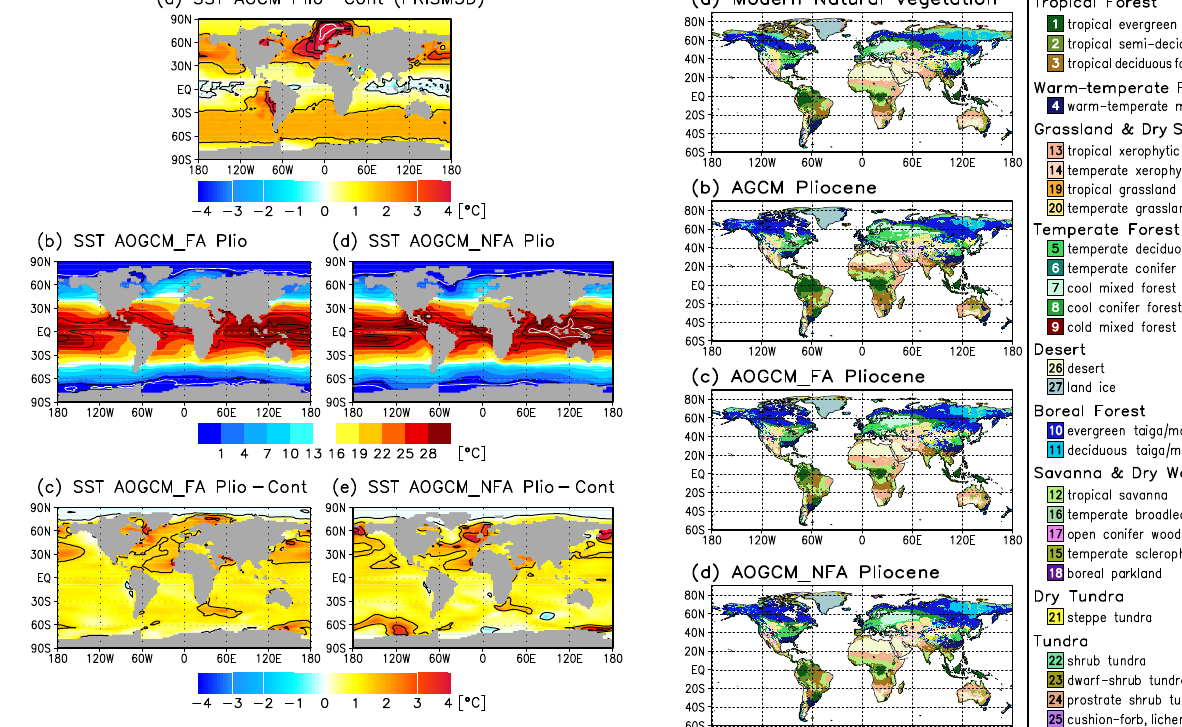
Fig. 9. (a) Present-day biomes simulated by BIOME4 model. (b) Biome distributions in Pliocene simulated with BIOME4 driven by the climate parameters predicted in AGCM (A_biome), (c) AOGCM_FA (AOFA_biome), and (d) AOGCM_NFA (AONFA_biome). Biomes were classified into 9 types of MEGABIOME category (bold) after Harrison and Prentice (2003).